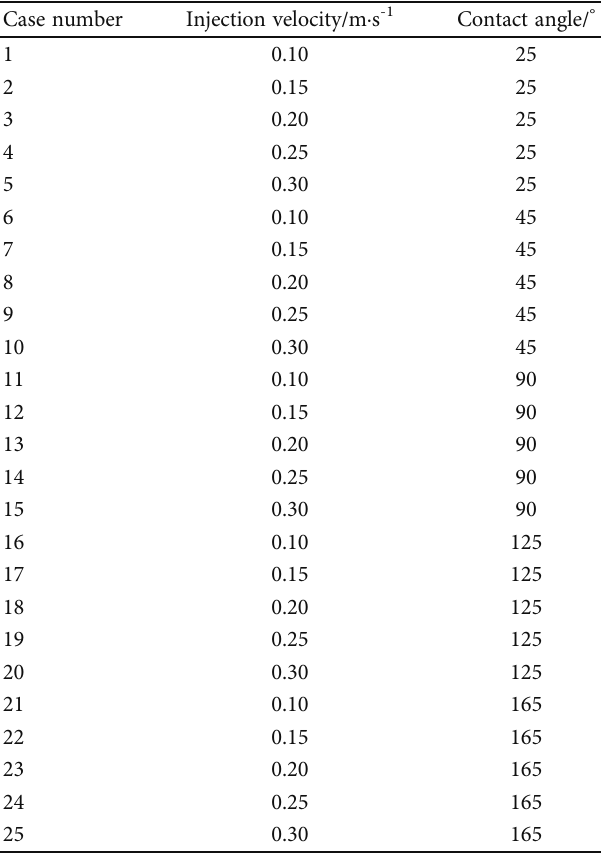
Table 3: Injection velocity and wall condition in di ff erent